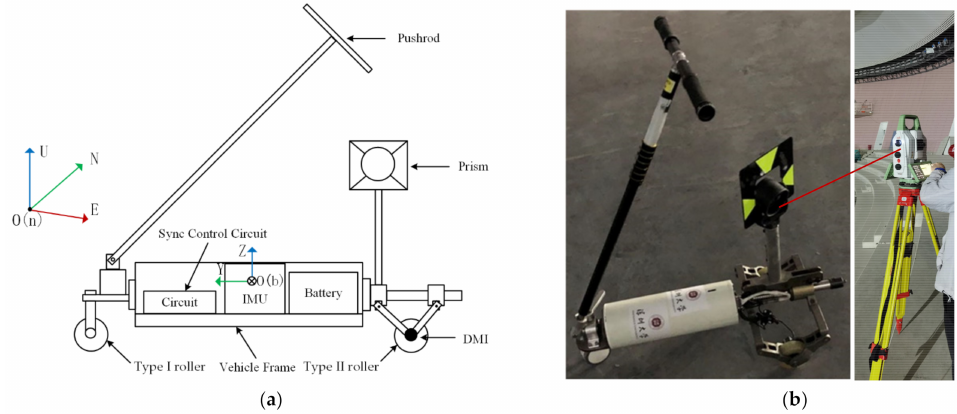
Figure 3. Wheeled robot. ( a ) Design of the measurement robot. ( b ) experimental